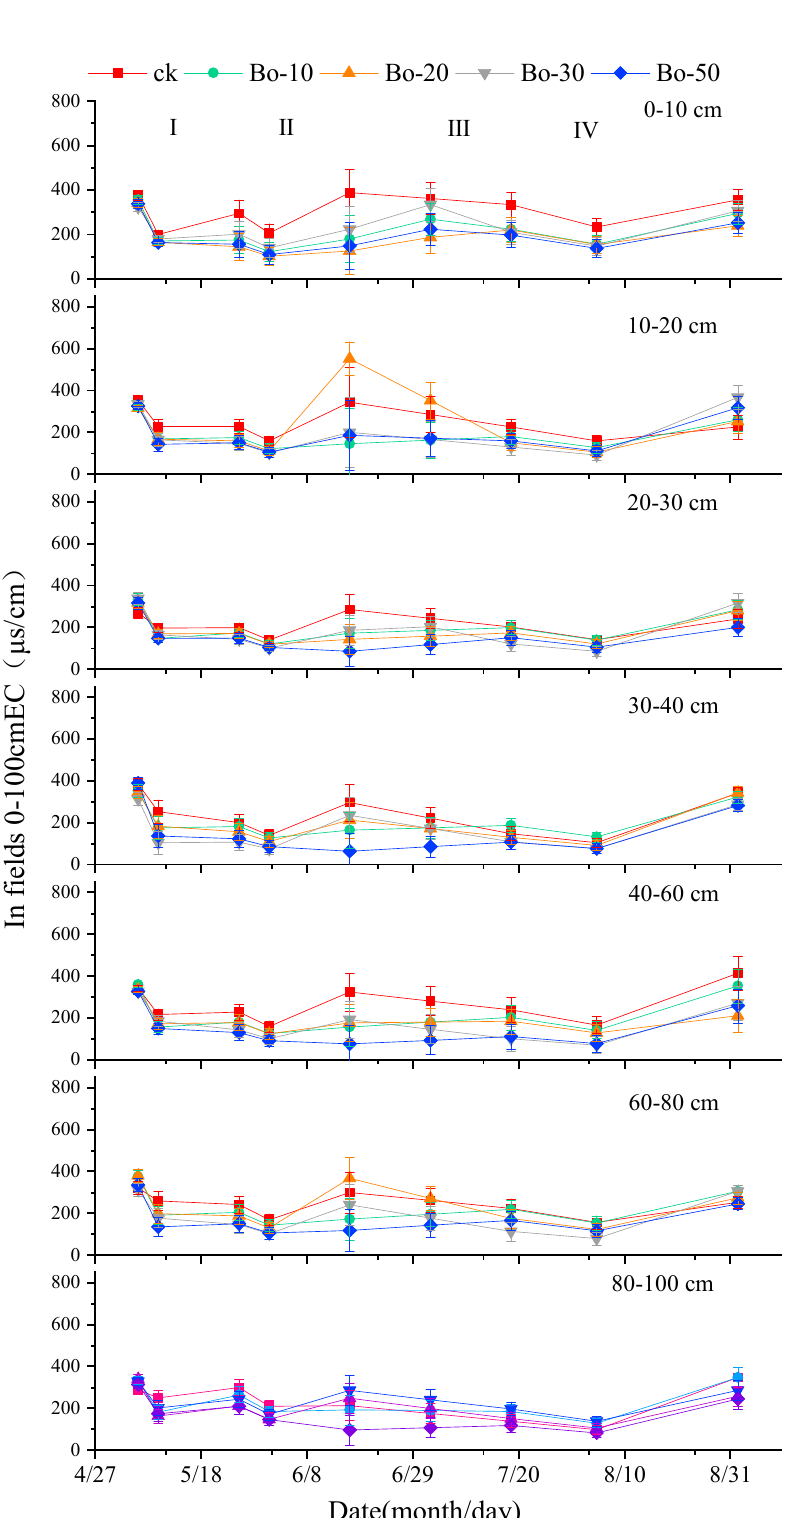
Figure 5. Variations of EC after adding straw biochar from the whole maize growth period in fields soil column (0–100 cm). Data are presented in the average with standard error bars ( n = 3).